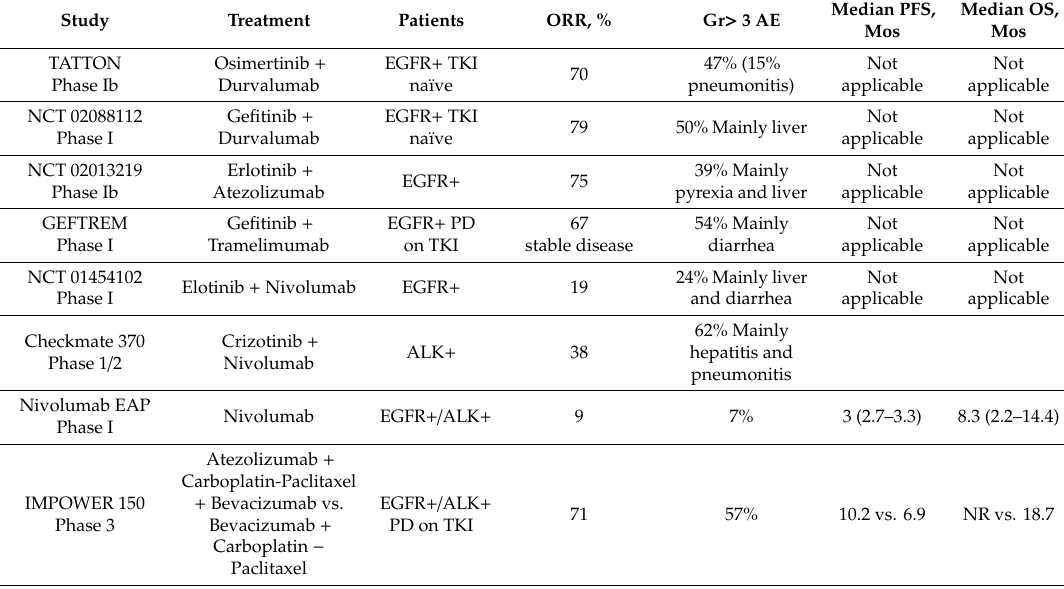
Table 1. Immunotherapy in oncogene-addicted disease.